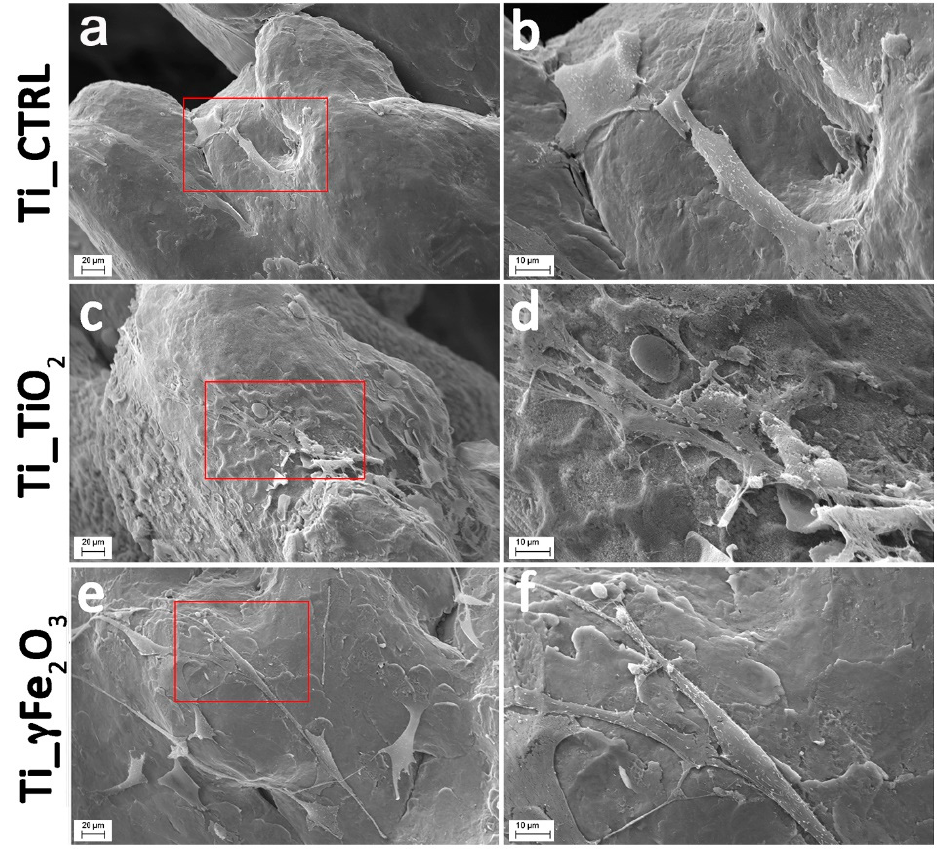
Figure 5. Representative SEM images of Ti_CTRL ( a , b ), Ti_TiO 2 ( c , d ) and Ti_ γ Fe 2 O 3 ( e , f ) scaffolds with hADSCs after 7 days from the seeding. Magnification 1000 × ( a , c , e ); magnification 3000 × ( b , d , f ).